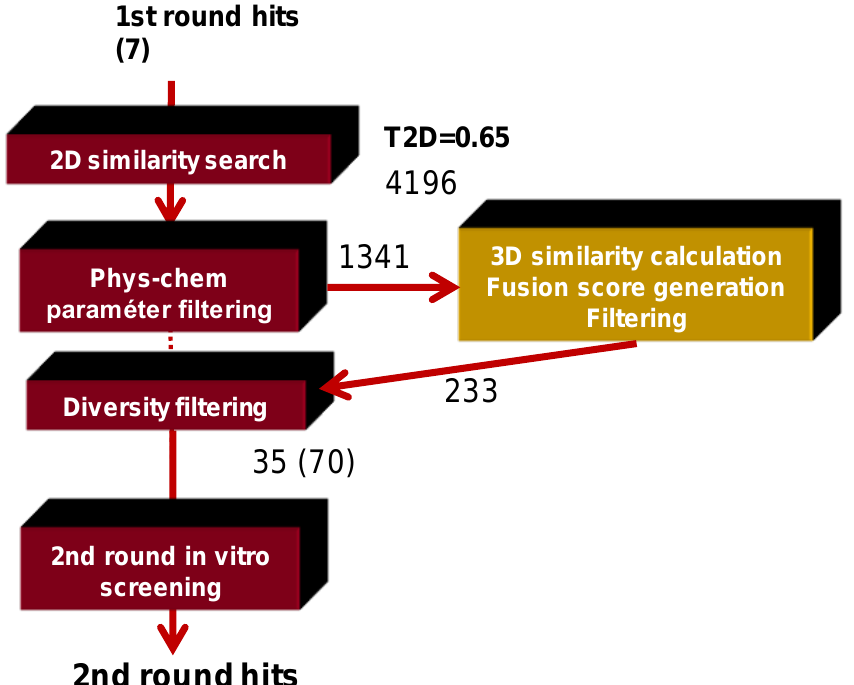
Figure 6. The workflow of applying the fusion core in the second round focused PDE4B inhibitor library generation.